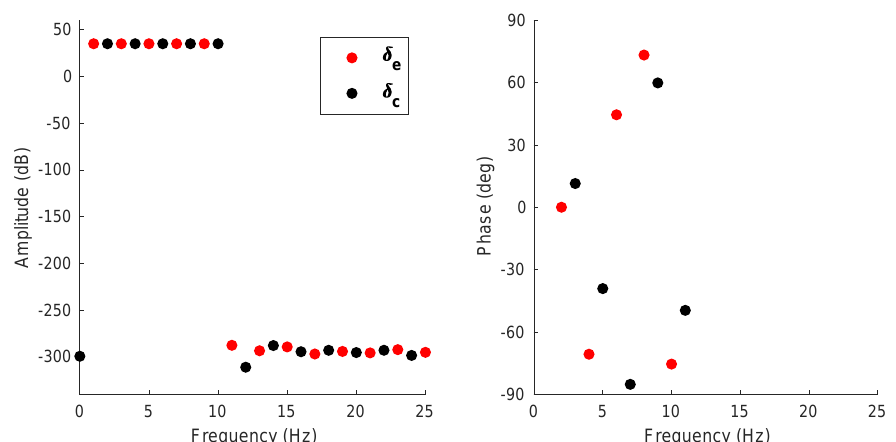
Figure 7. Amplitudes ( left ) and phases ( right ) of the multisine frequency separated elevator and canard input signals. The phases corresponding to low-amplitude frequencies are omitted in the right figure. The excitation has odd frequencies for the elevator (red) and even for the canard (black).